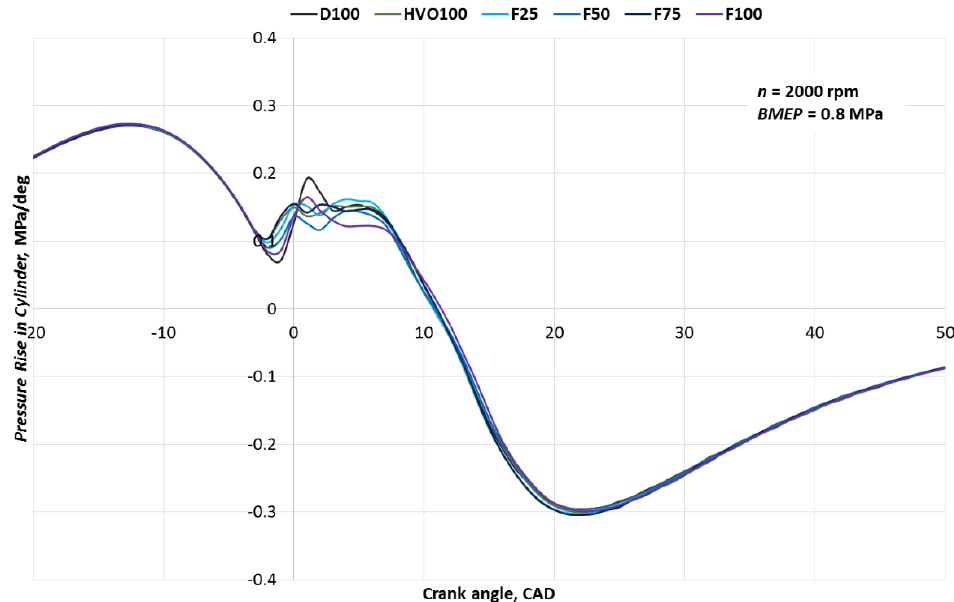
Figure 5. Dependence of the pressure rise in the cylinder using different fuels. Peak pressure varies little, but pressure at the end of compression and start of com- bustion is higher with added fat (Figure 6). This means that the burning of fat is longer. The longer combustion duration was determined due to the higher consumption (lower LHV), the longer injection duration, which was further increased by the higher fuel viscos- ity. Exhaust gas flow energy became higher and this increased the turbocharger pressure. However, longer combustion duration of fat reduced the